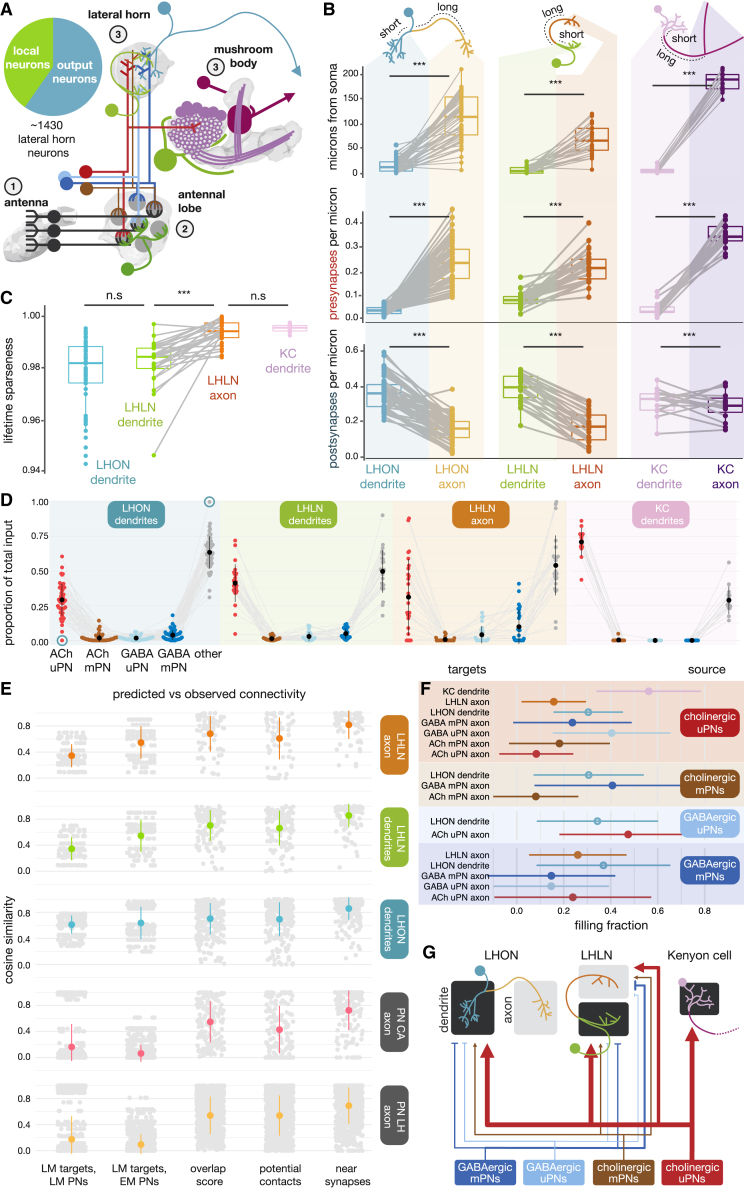
Feedforward Olfactory Input to Innate Center Neurons(A) Neuroanatomical schematic of the first three layers of the insect olfactory system. Pie chart shows proportion of local and output neurons among an estimated ∼1,400 LHNs.(B) Paired boxplots comparing key metrics between for third-order olfactory neurons’ dendrites versus their axons. Paired Student’s t test, ∗∗∗p ≤ 0.001.(C) Lifetime sparseness [45] for third-order olfactory neuron compartments sampling the uPN population (∼80 cell types). Lifetime sparseness is a measure of selectivity that is calculated separately for each single neuron across all patterns (i.e., weighted input connectivity vector), the higher the value the sparser the neuron. Paired Student’s t test, ∗∗∗p ≤ 0.001.(D) Proportion of synaptic inputs supplied by feedforward olfactory drive from the AL (pooled by neuron class and compartment). Blue circle highlights LHPV5g1#1, a putative LHON that receives little second-order olfactory input.(E) Cosine similarity between different methods of synaptic prediction and observed synaptic connectivity in the EM dataset (see STAR Methods). Only olfactory PN connectivity onto different classes of downstream target (facets) are considered. LM = registered light microscopy data [8, 30]. Cosine similarity examines whether neurons connect to the same targets in similar proportions (it is the cosine of the angle between connectivity vectors in a multi-dimensional space).(F) The weighted mean (± SD) of the filling fraction between two neurons (no connections predicted by looking for nearby presynapses divided by observed connections), for olfactory PN connections onto different classes of downstream targets. Only results statistically significantly different from the PN→LHON dendrite filling fraction (open circle, blue) are shown (weighted Student’s t test). Number of near synapses used as the weights.(G) Schematic of feedforward input from the AL to the LH and CA.See also Figure S4; Data S1 and S4.